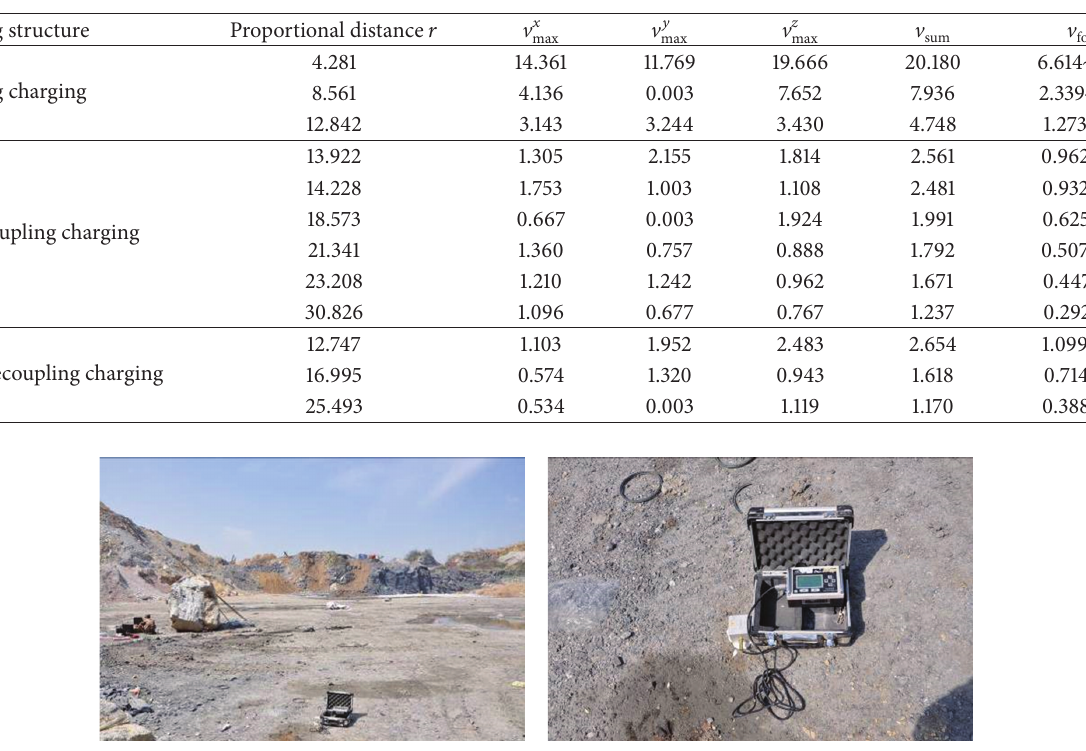
Table 1: Peak vibration velocity of different charging structures at measuring points (cm/s).